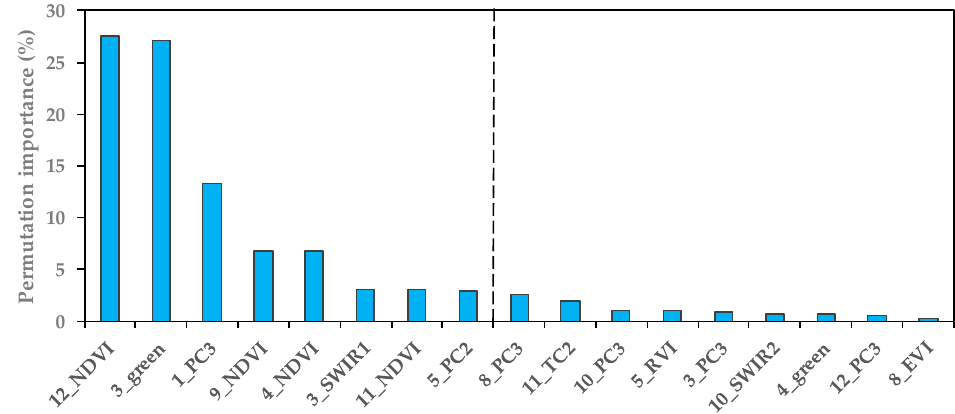
Figure 9. Bands’ contributions are sorted in descending order with the permutation importance value output by the Time-Series 2 model. Bands (x-axis): the number stands for the month of the year, followed by the name of the variable. The sum of the permutation importance value from the months with two time-series models exceeds 90% of the total, depicted by the gray dotted line.